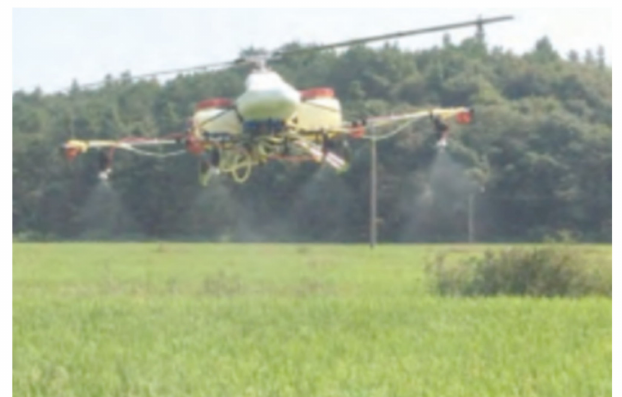
Figure 2. Rice field test with an XY8D UAV-based electrostatic spray system